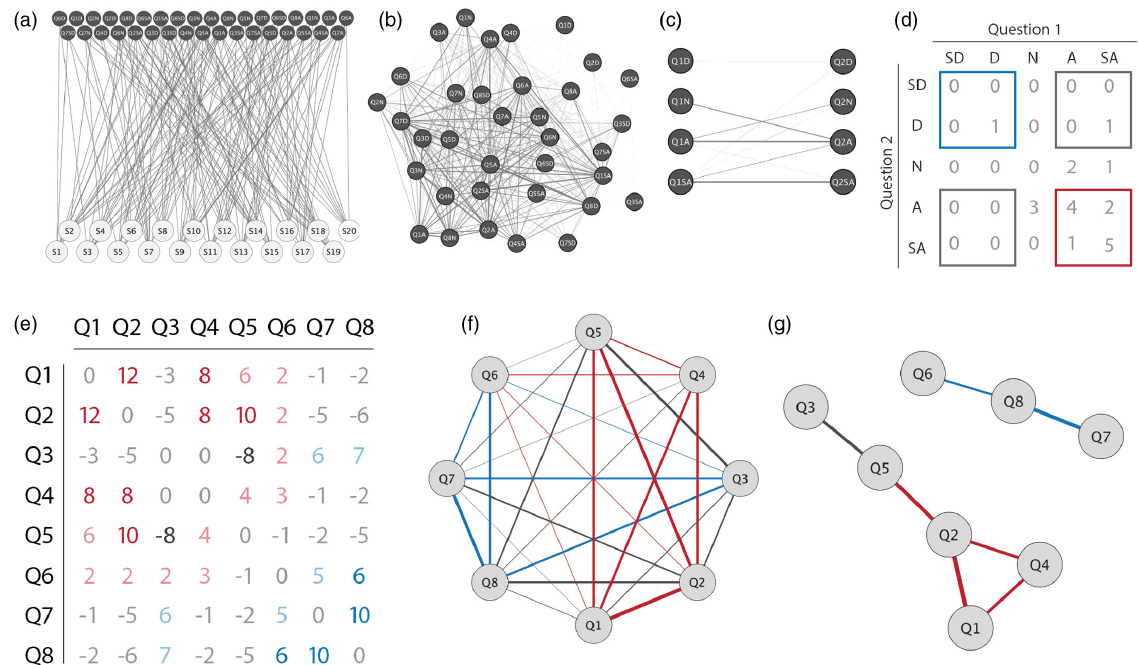
FIG. 1. Visualization of generating a network based on Likert-style survey responses. (a) Bipartite network of students (light gray) and response selections (dark gray). (b) Projection of bipartite network onto the response selections, weighted by number of students connecting. (c) Network of response selections for just Q1 and Q2. (d) Adjacency matrix representation of Q1 and Q2 response network with the negative temperature relationships boxed in blue, the positive temperature relationships boxed in red, and the inverse relationships boxed in gray. The same color scheme is used in the remaining panels. (e) Adjacency matrix of the survey item network after collapsing the response network with significant edge weights in bold. (f) A full survey item network with all edges included. (g) A backbone survey item network with only significant